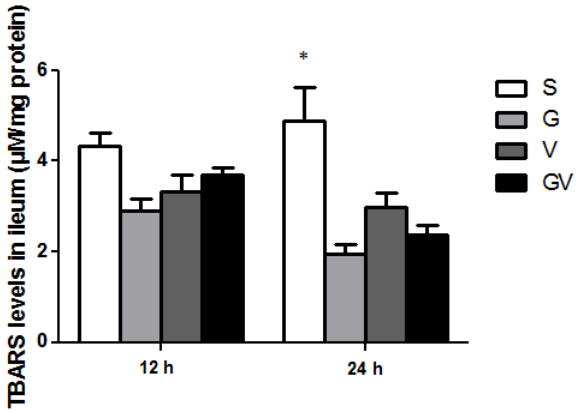
Figure 8. Thiobarbituric-acid-reactive substance (TBARS) levels in ileum tissues after cecal ligation and puncture at two time points. The groups are described in the legend of Figure 1 (n = 8 in each group). Values are expressed as the mean ± SEM. Differences among groups at the same time point were analyzed by a one-way analysis of variance using Tukey’s post hoc test. * Significantly differs from the other groups at the same time point ( p < 0.05).